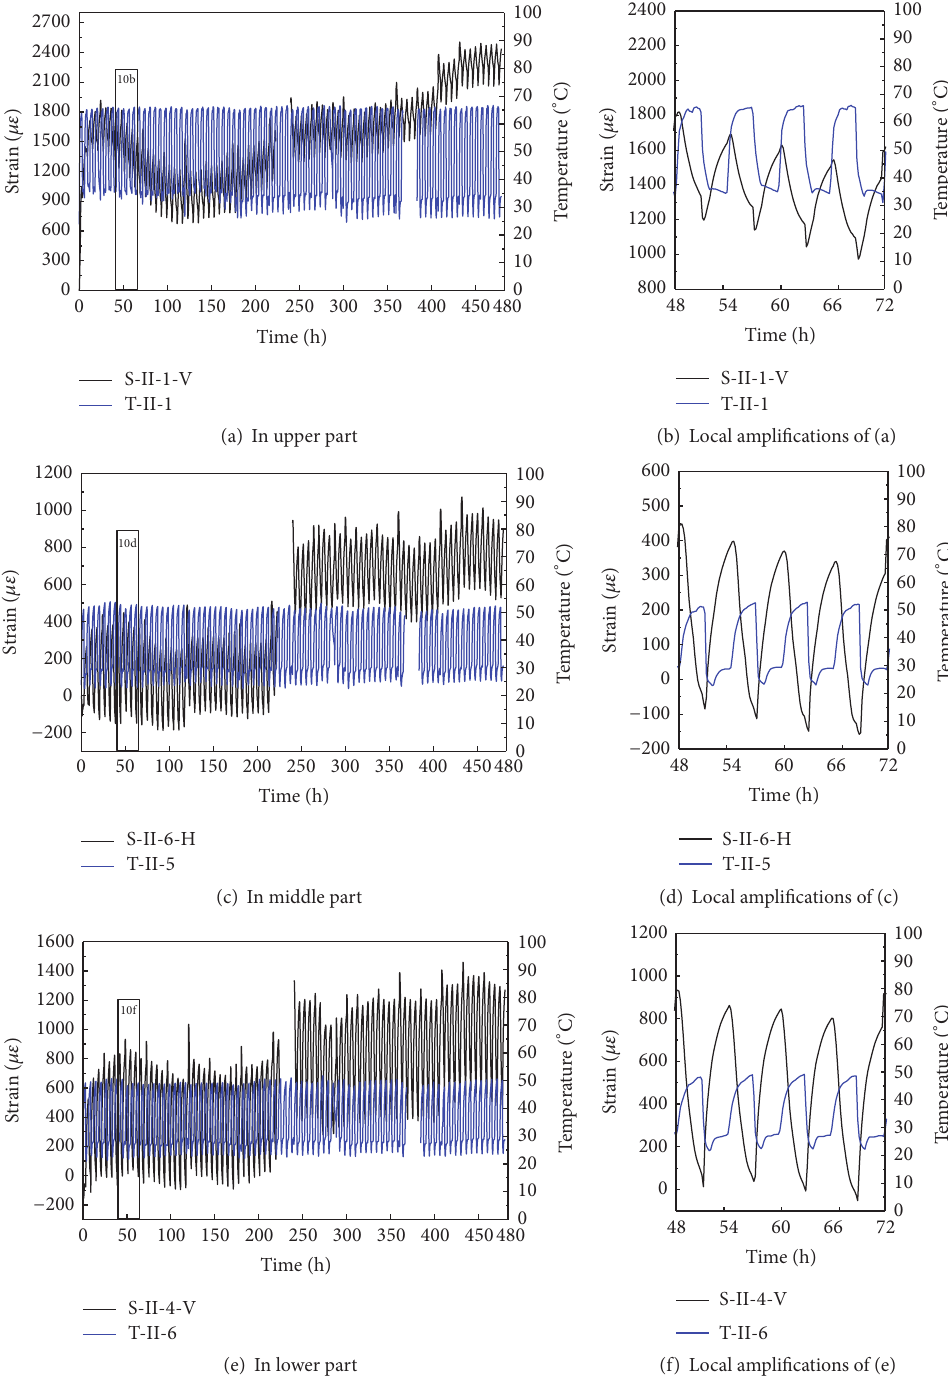
(3) The strain-time relationship changing curve may be divided into three stages (see Figure 14). Before the 20th hygrothermal cycle, the strain of each structural